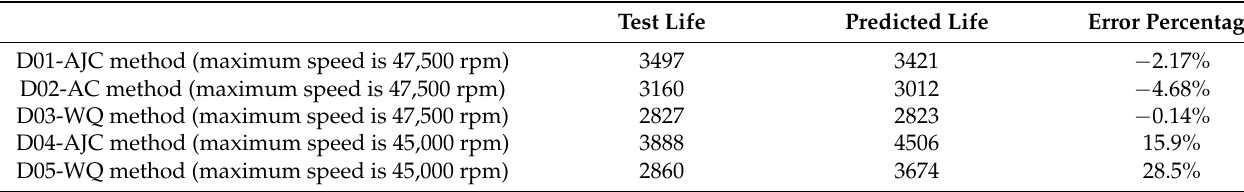
Table 6. Comparative analysis between simulation and test results.